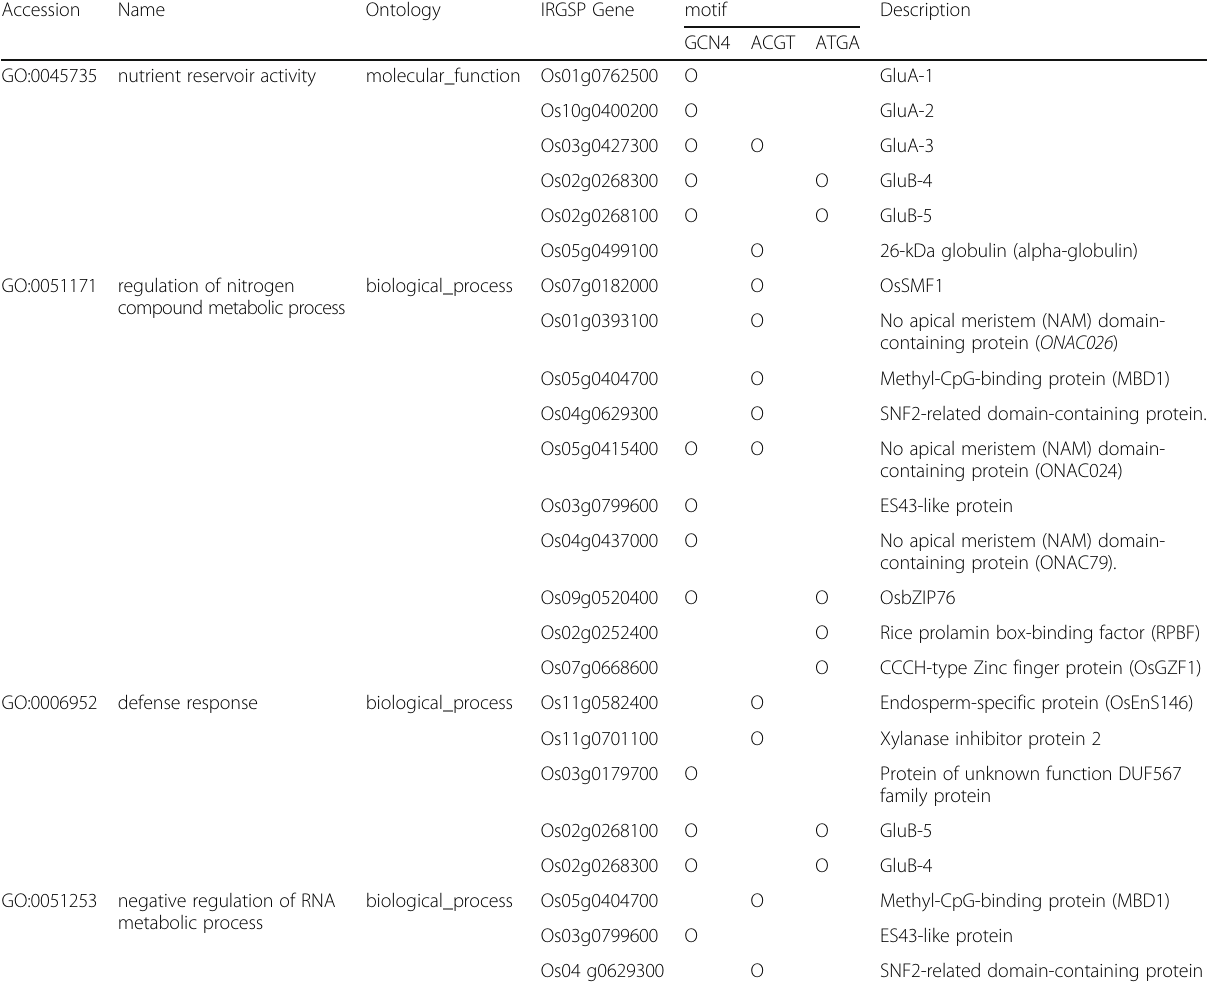
Table 2 Gene Ontology classification of putative OsSMF1 target genes